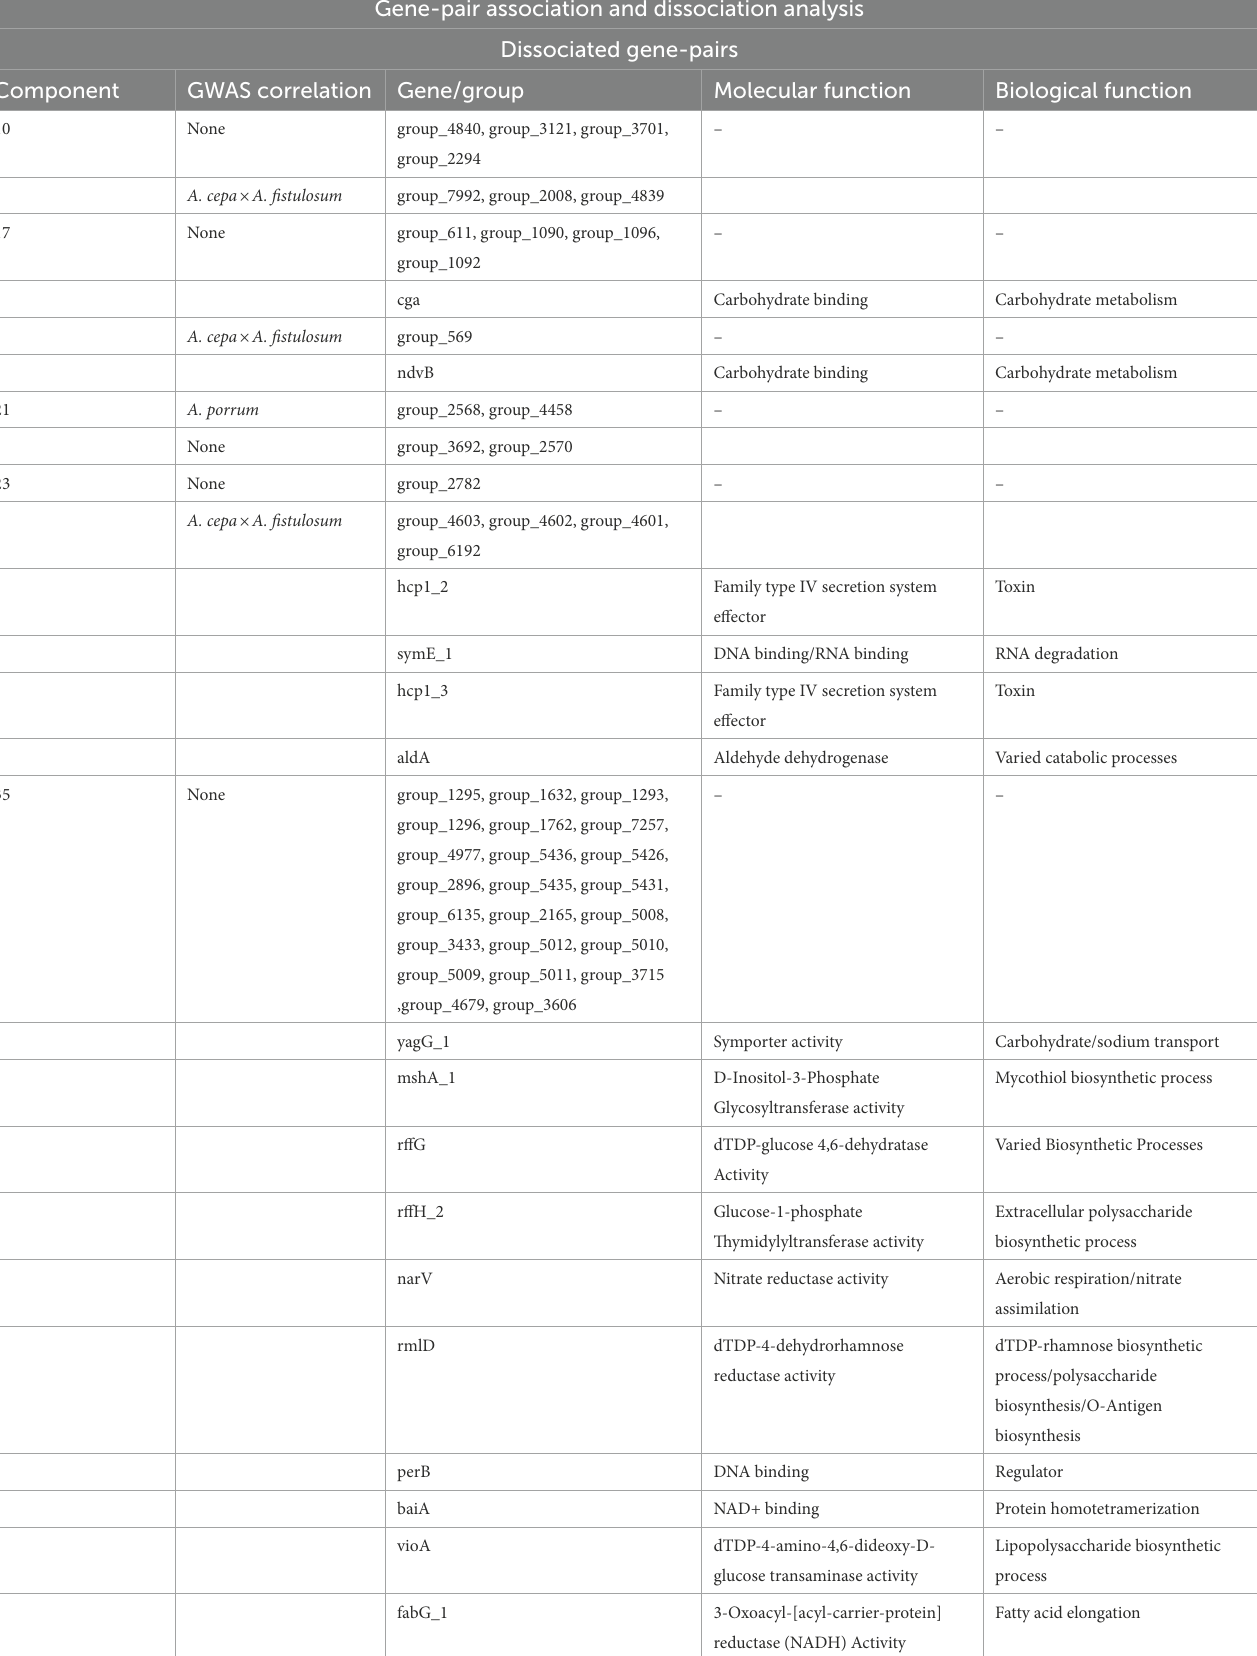
TABLE 3 List of gene-pair disassociation components that contain genes shared with the predicted genes from the genome wise association studies (GWAS) results. Gene-pair association and dissociation analysis Dissociated gene-pairs Component GWAS correlation Gene/group Molecular function Biological